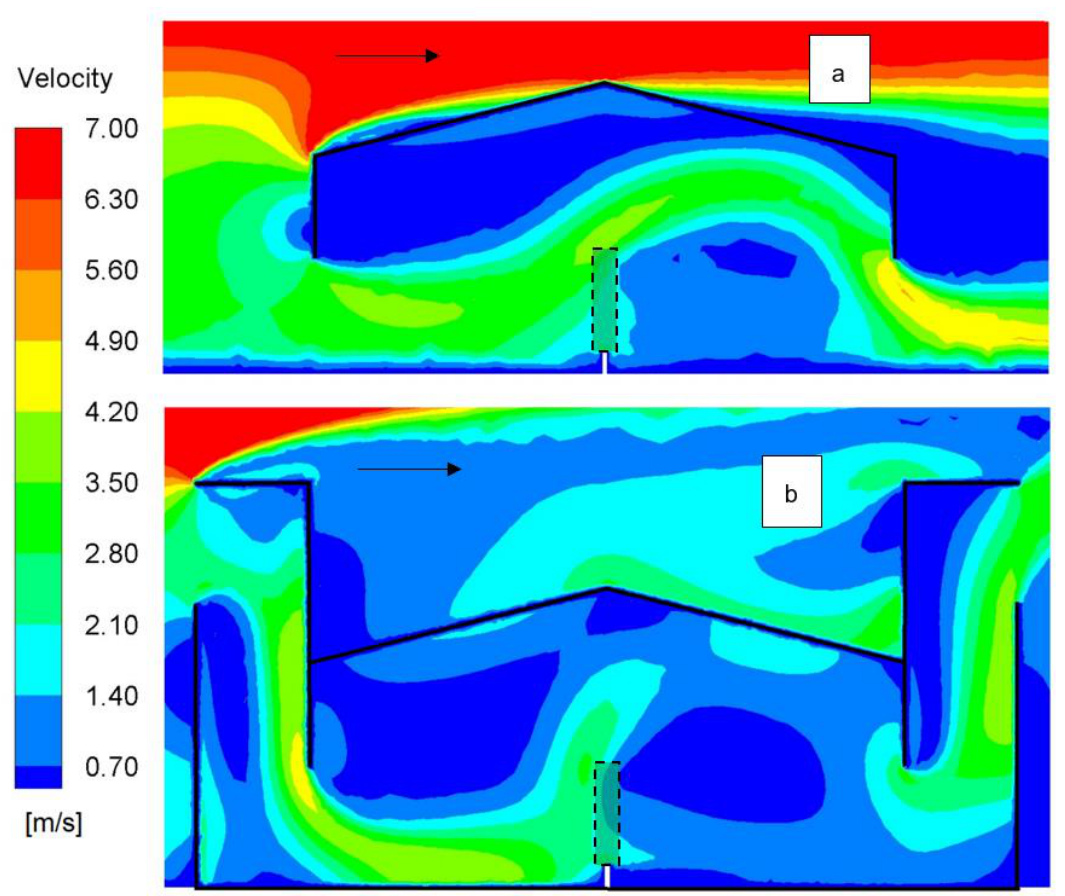
Figure 10. Simulated air velocity contours at the midplane of the greenhouse with a row of plants at the centre: ( a ) with cross-flow ventilation and ( b ) with windcatchers. Energies 2020 , 13 , x FOR PEER REVIEW 13 of 24